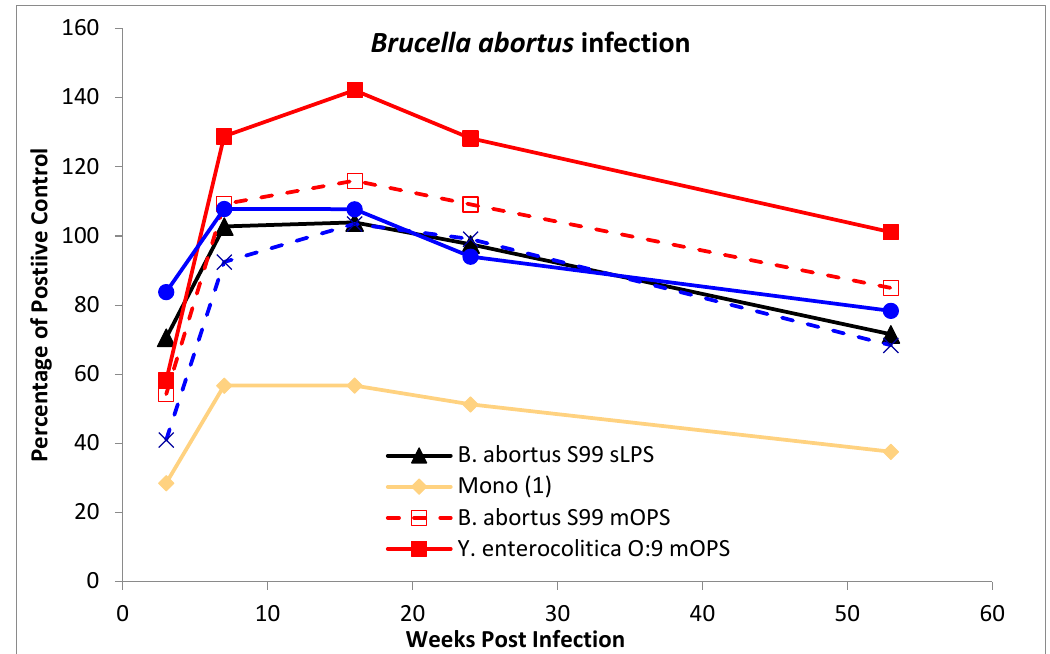
Figure 3. Average results from iELISA performed with sera collected from four cattle experimentally infected with B. abortus strain 544 and at five sampling dates (3, 7, 16, 24 and 53 weeks post infection) as show on the x -axis. The graph shows results against B. abortus S99 sLPS (solid black line), B. abortus mOPS (dashed red line), Y. enterocolitica O:9 mOPS (solid red line), 2,2,2,2,2-Hexa (9) (dashed blue line), 2,2-Tri (5) (solid blue line) and Mono (1) antigens (solid yellow line). The iELISA results ( y -axis) are expressed as a percentage of a common positive control that was applied to each antigen type.